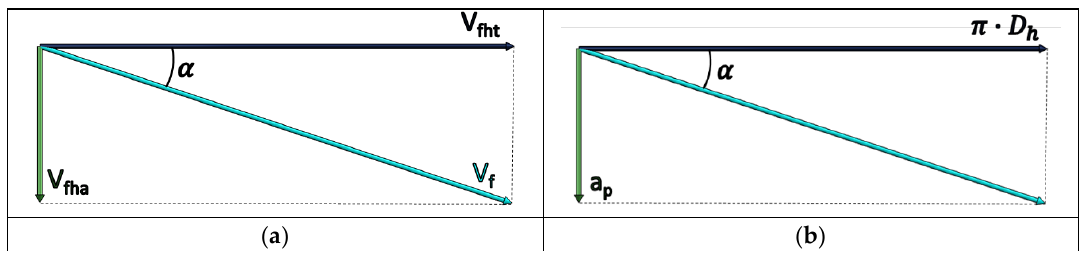
Figure 3. Feed decomposition: (a) Decomposition of the feed rate in tangential speed and axial speed, (b) Decomposition advance per helical revolution in pitch per helical revolution and perimeter of the helix trajectory.